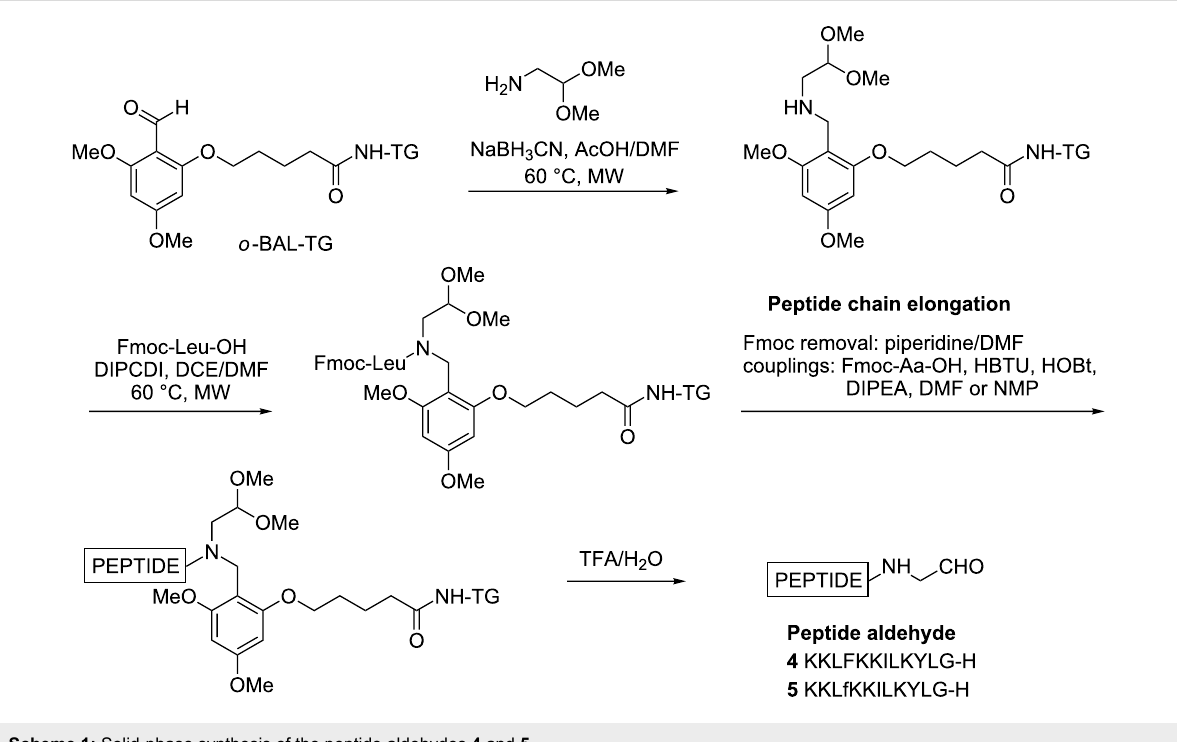
Scheme 1: Solid-phase synthesis of the peptide aldehydes 4 and 5 .